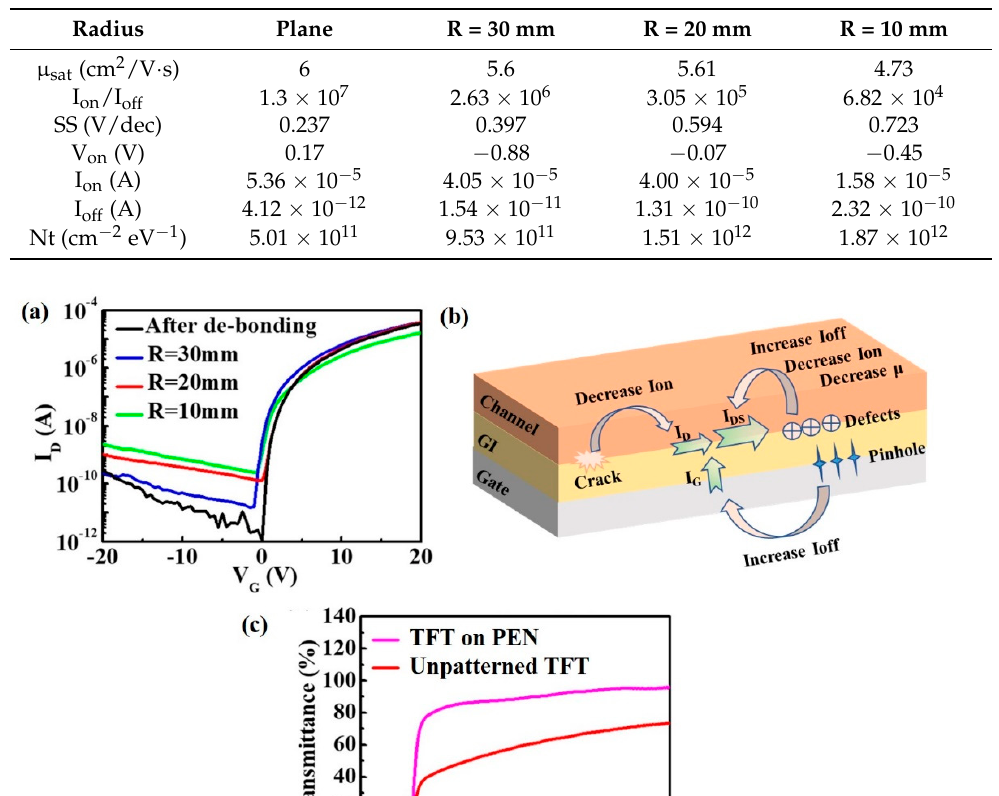
Table 1. Summary of the performance of the flexible TFT after bending.